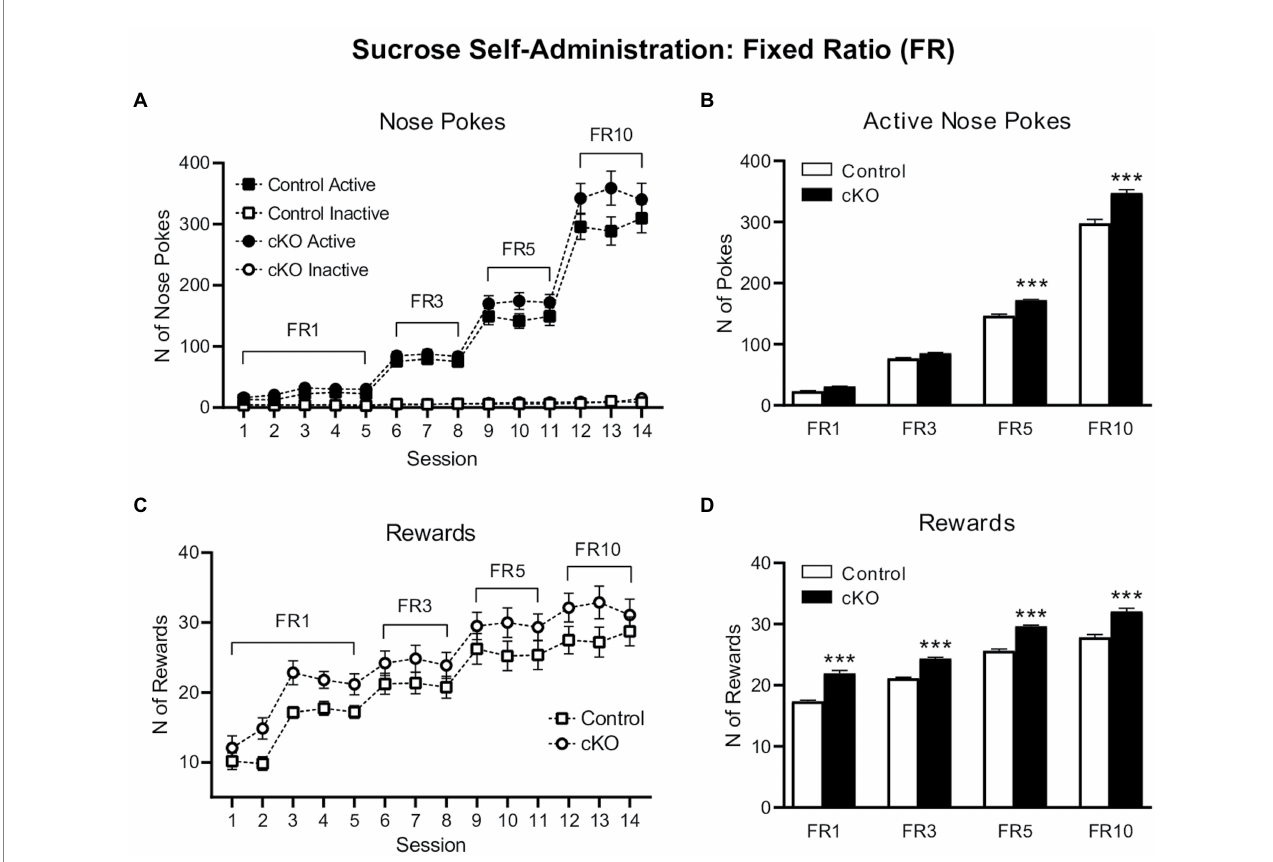
FIGURE 2 Active (filled symbols) and inactive (clear symbols) nose pokes of control (squares) and cKO (circles) mice throughout the Fixed Ratio (FR) sessions (A) . Average of active nose pokes of control (white bars) and cKO (black bars) mice in FR1, FR3, FR5 and FR10 sessions (B) . Rewards obtained by control (squares) and cKO (circles) throughout the Fixed Ratio (FR) sessions (C) . Average of rewards gained by control (white bars) and cKO (black bars) mice in FR1, FR3, FR5 and FR10 sessions (D) . Data are expressed as mean ± SEM. *** p < 0.001 Sidak’s multiple comparisons test vs. control